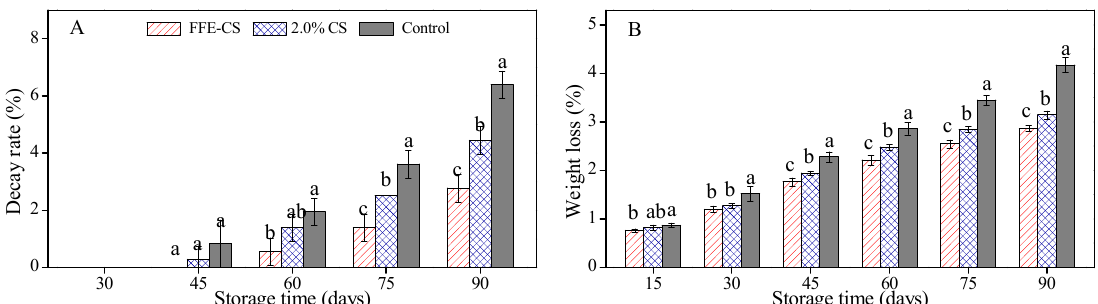
Figure 3. Effect of FFE-CS coating on decay rate ( A ) and weight loss ( B ) of Xinyu tangerines during cold storage of 90 days. Differences between treatments for each time were analyzed using Duncan’s multiple range test at P < 0.05.